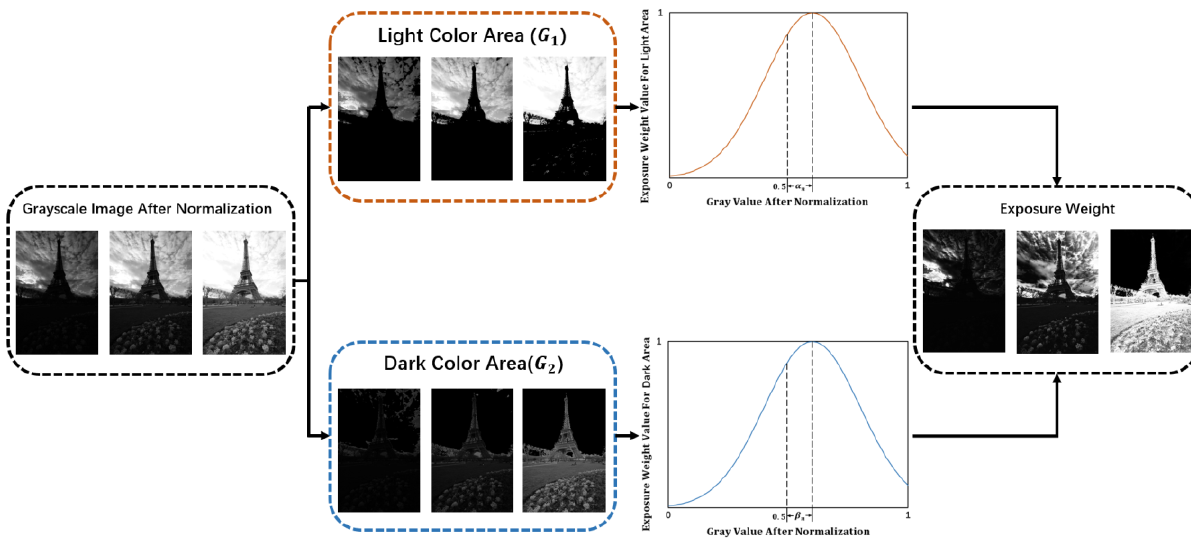
Figure 3. Process diagram of exposure weight map calculation.